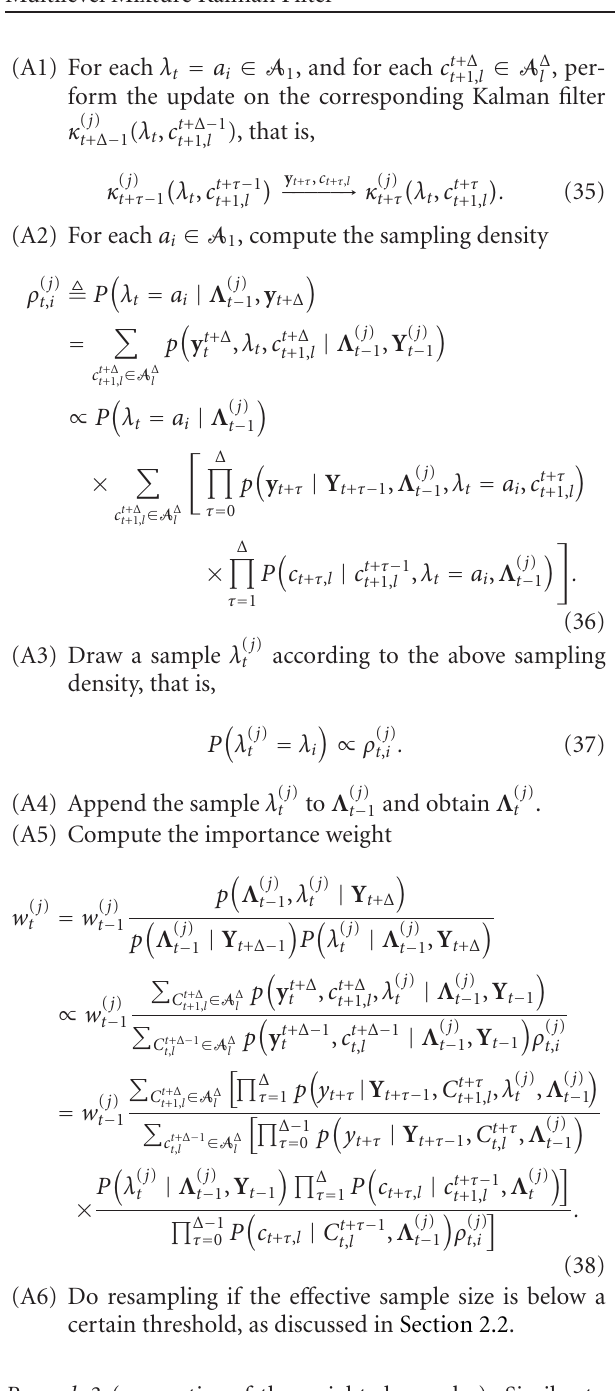
Algorithm 5 (alternative sampling method). (1) At time t + ∆